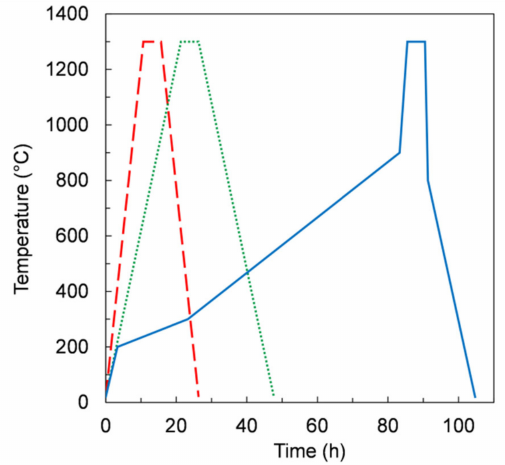
Figure 10. Temperature profile versus time in the debinding and sintering thermal treatments TT1 (dashed line), TT2 (dotted line), and TT3 (solid